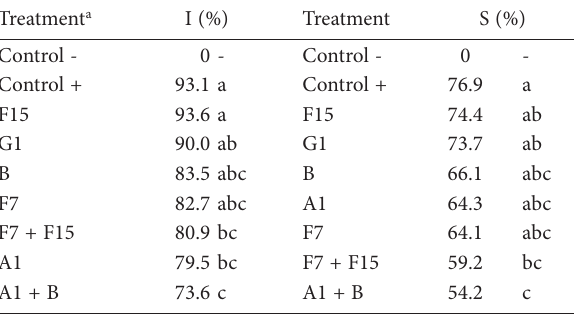
Table 6. Mean incidence (I) and severity (S) of Fusarium foot rot ( Fusarium c ulmorum ) on wheat “Simento” seedlings after seed treatments with different bacterial endophyte